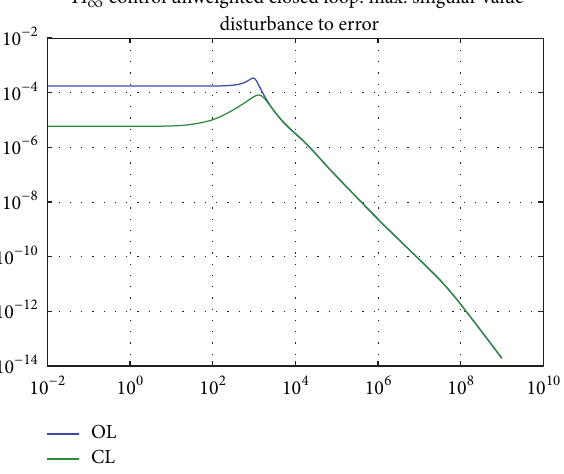
Figure 14: Maximum singular value plots for